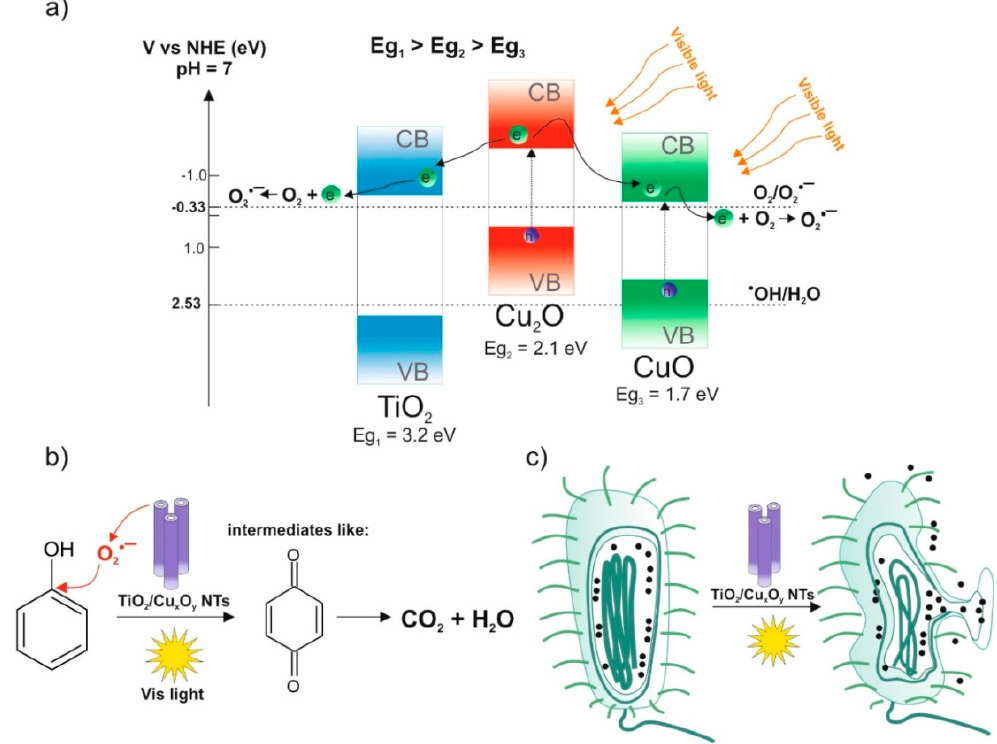
Figure 6. A suggested scheme of ( a ) visible light excitation mechanism in presence of TiO 2 -Cu 2 O and CuO NTs, ( b ) phenol degradation pathway under Vis light, and ( c ) inactivation of bacterial cell